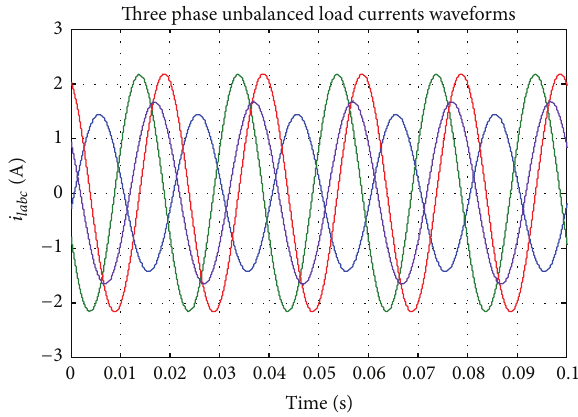
Figure 8: Three-phase unbalanced nonlinear and neutral load cur- rents waveforms.